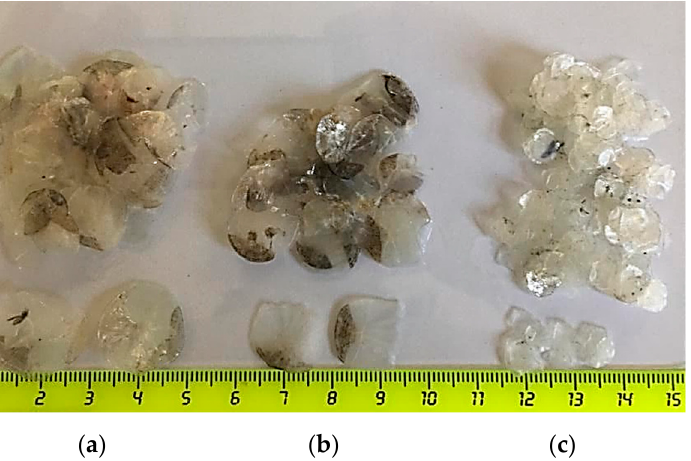
Figure 1. Camera photo of fish scales of abramis brama ( a ), carassius carassius ( b ), and sander lucioperca ( c ). erca ( c A mixture containing 20 wt.% abramis brama fish scales, 20 wt.% carassius carassius